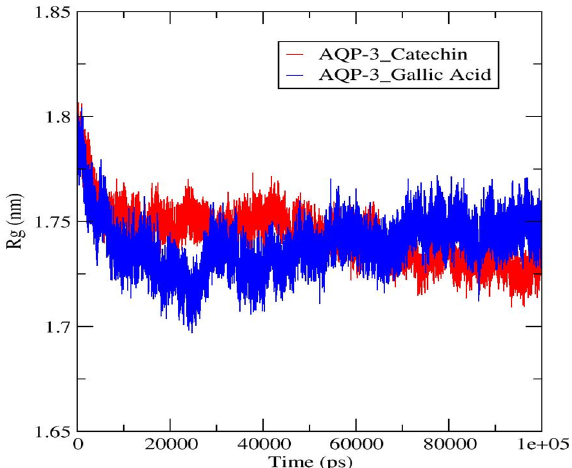
Figure 12. Average Rg value for the AQP-3-gallic acid and -catechin complexes.